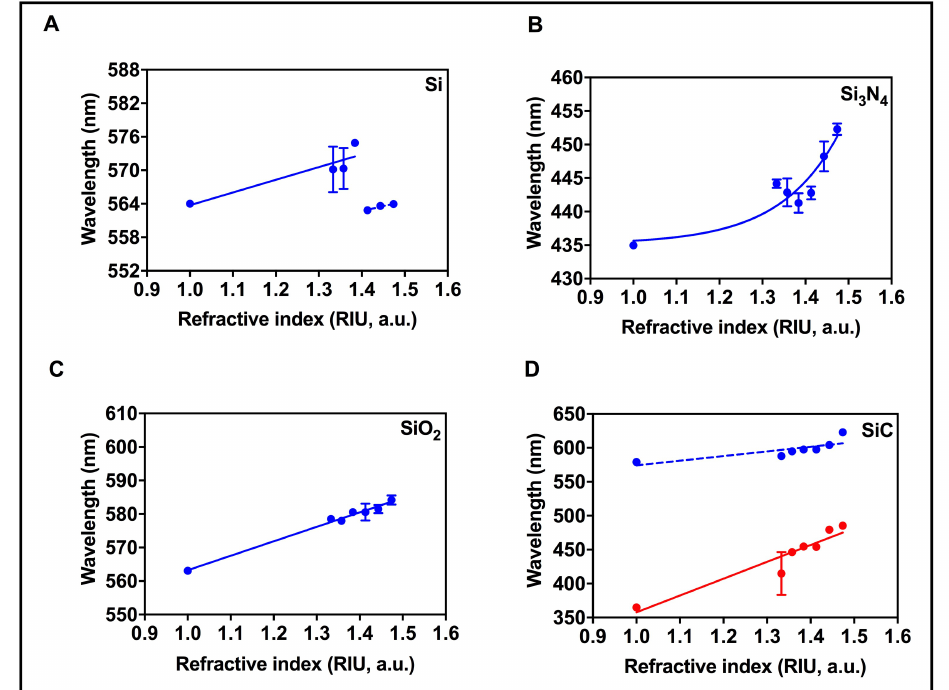
Figure 5. Refractive index characterization: The panels ( A – D ) display the changes in the LSPR wavelength of the AuNI when the refractive index varies from 1.00 to 1.47 on Si, Si 3 N 4 , SiO 2 and SiC substrates